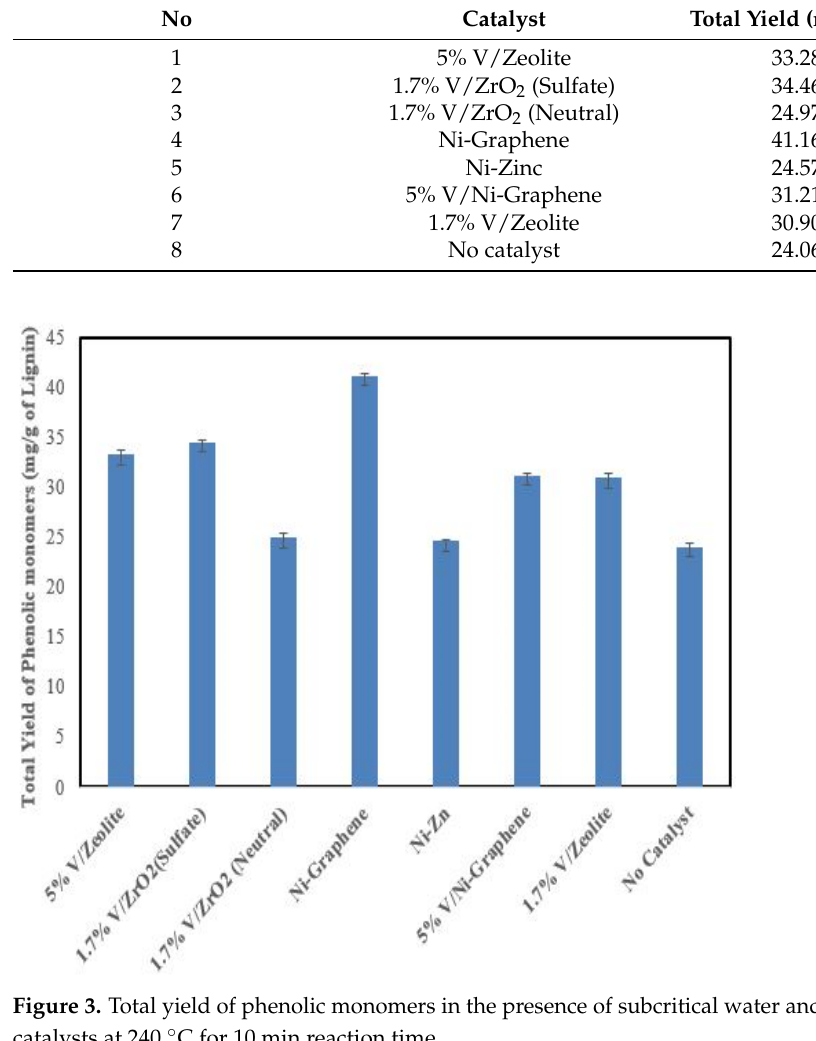
Figure 3. Total yield of phenolic monomers in the presence of subcritical water and different types of catalysts at 240 °C for 10 min reaction